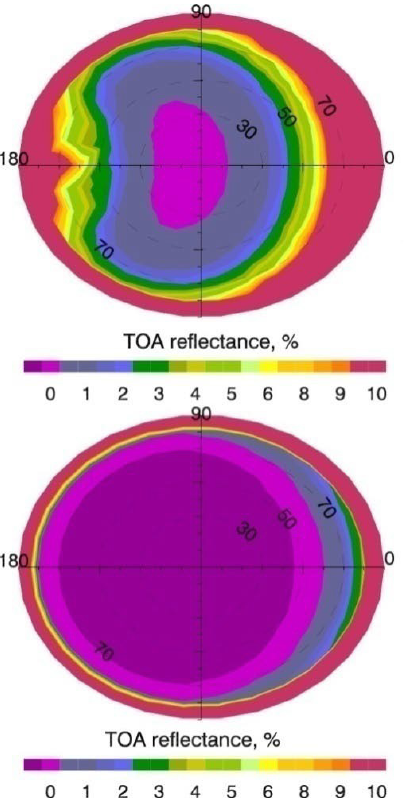
Fig. 3. Angular behavior of aerosol reflectance for coarse mode of dust aerosol component 550nm (upper panel) and at 3.7µm (lower panel). Sun zenith angle is equal to 65 degrees, AOT=0.1.